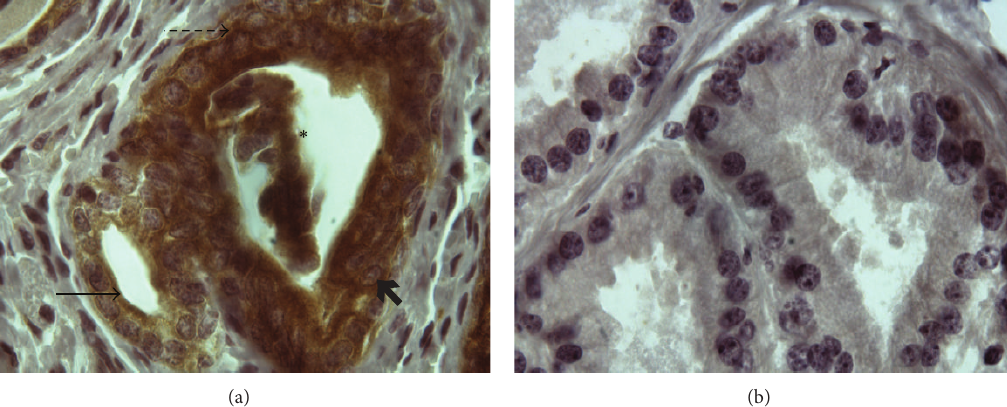
Figure 4: PAR1 is expressed in the wild-type mouse prostate. Prostates were treated with sterile saline and sacrificed 2 days posttreatment. PAR1 expression was localized via immunohistochemistry and was as follows. (a) Positive PAR1 staining throughout the apical acini epithelium (arrow), prostatic acini lumen ( ∗ ), basal acini epithelium (dashed arrow), and prostatic epithelial cells (arrowhead) in wild- type mice. (b) Negative PAR1 staining in PAR1 knockout (PAR1 −/− ) mice. Sections were counterstained with hematoxylin; original magnification